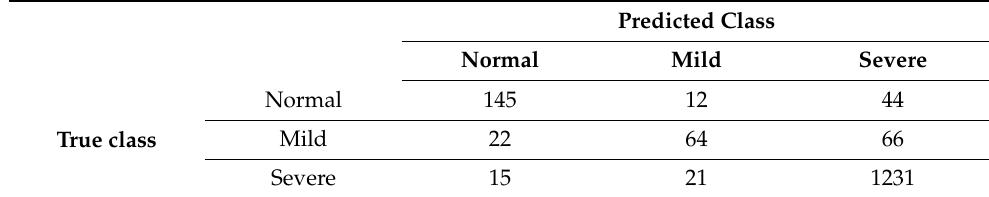
Table 5. Confusion matrix for the M-specific GCNN predictions. Rows show the N, M, and S groups, while columns show the number of cells predicted for each group.